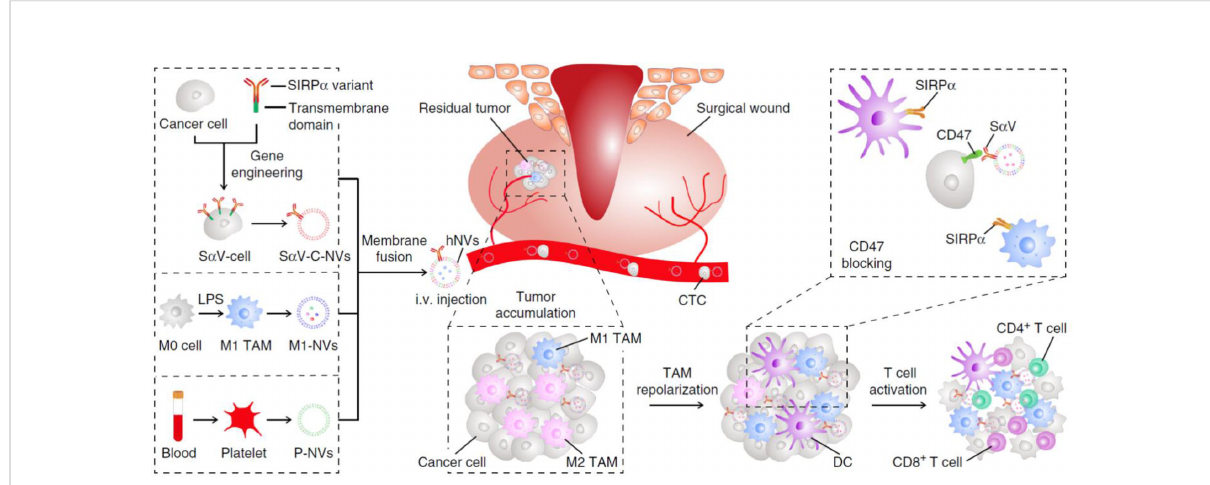
FIGURE 5 The hNVs consist of S a V-C-NVs, M1-NVs, and P-NVs, they could ef fi ciently interact with CTCs in the blood, accumulate in the post-surgical site, repolarize TAMs towards M1 phenotype, and block the CD47-SIRP a ‘ don ’ t eat me ’ pathway to promote phagocytosis, eventually boosted antitumor T cell immunity, reproduced from ref